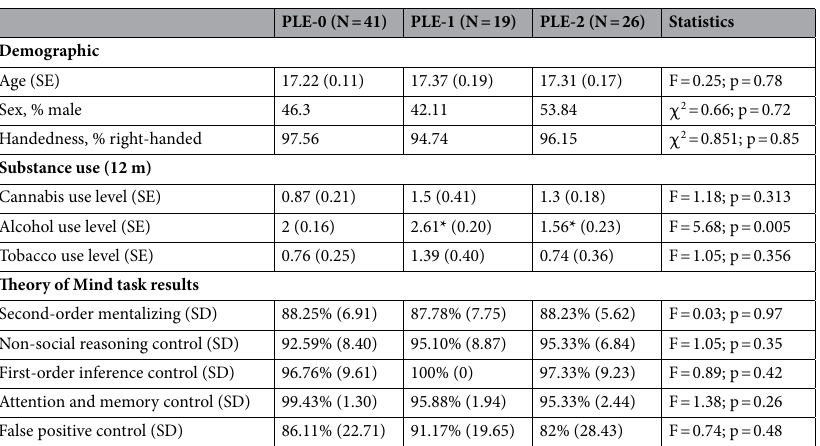
Table 1. Demographic characteristics of the study sample. SE = Standard Error; SD = Standard Deviation; Substance use rated on a 6-point scale; The theory of mind task looked at stories of false belief which served as a measure of second-order mentalizing, control items tested non-social reasoning, first-order inference, questions to control for attention and memory effect, and items to control for false-positives. Mean percentage of correct answers in each category. PLE-0 = control trajectory; PLE-1 = decreasing trajectory; PLE-2 = increasing trajectory. * Significant difference.